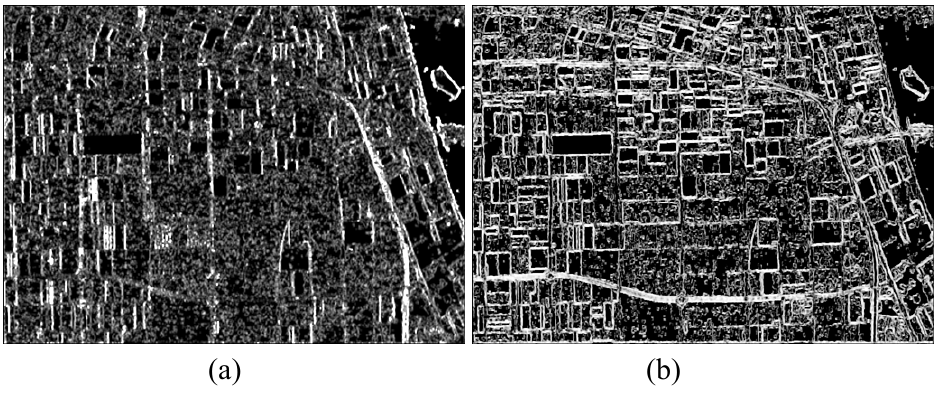
. ( a ) Contrast; ( b ) Correlation; ( c ) Energy; ( d ) 33